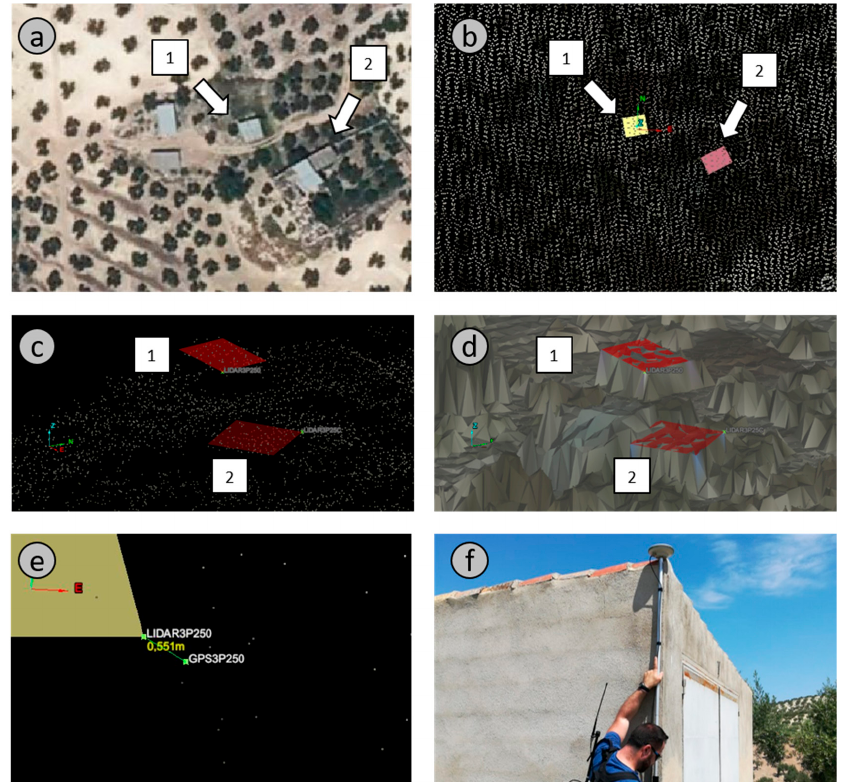
Figure 4. Measurement of roof corners for ground control/check points: ( a ) aerial image of two agricultural sheds (1,2) used for ground control/check points extraction; ( b ) LiDAR point cloud with the flat roofs of the sheds marked; ( c ) minimum bounding rectangles adjusted to the LiDAR points located on top of the flat shed roofs. LiDAR point cloud is also represented; ( d ) minimum bounding rectangles adjusted to the LiDAR points located on top of the flat shed roofs. DSM is represented; ( e ) corner of the minimum bounding box and field-measured GNSS. The distance represents the error between the corner measured in field (with GNSS) and that computed with the minimum bounding box adjusted to the LiDAR points on top of the roof; ( f ) GNSS field-measurement of a shed roof corner.